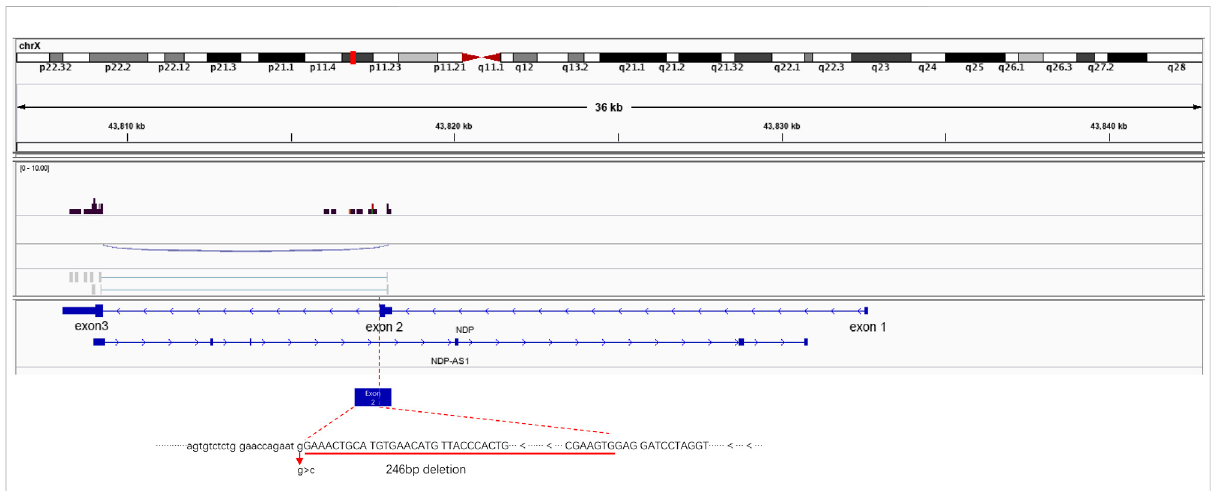
FIGURE 4 Illustrative examples of variant splicing analysis. RNA-seq was performed to a ×2 sequencing depth to detect the NDP -associated RNA. The results were compared to the wild-type transcript sequences. It was found that there was a 246 bp deletion at the 3 ′ end of NDP exon 2.